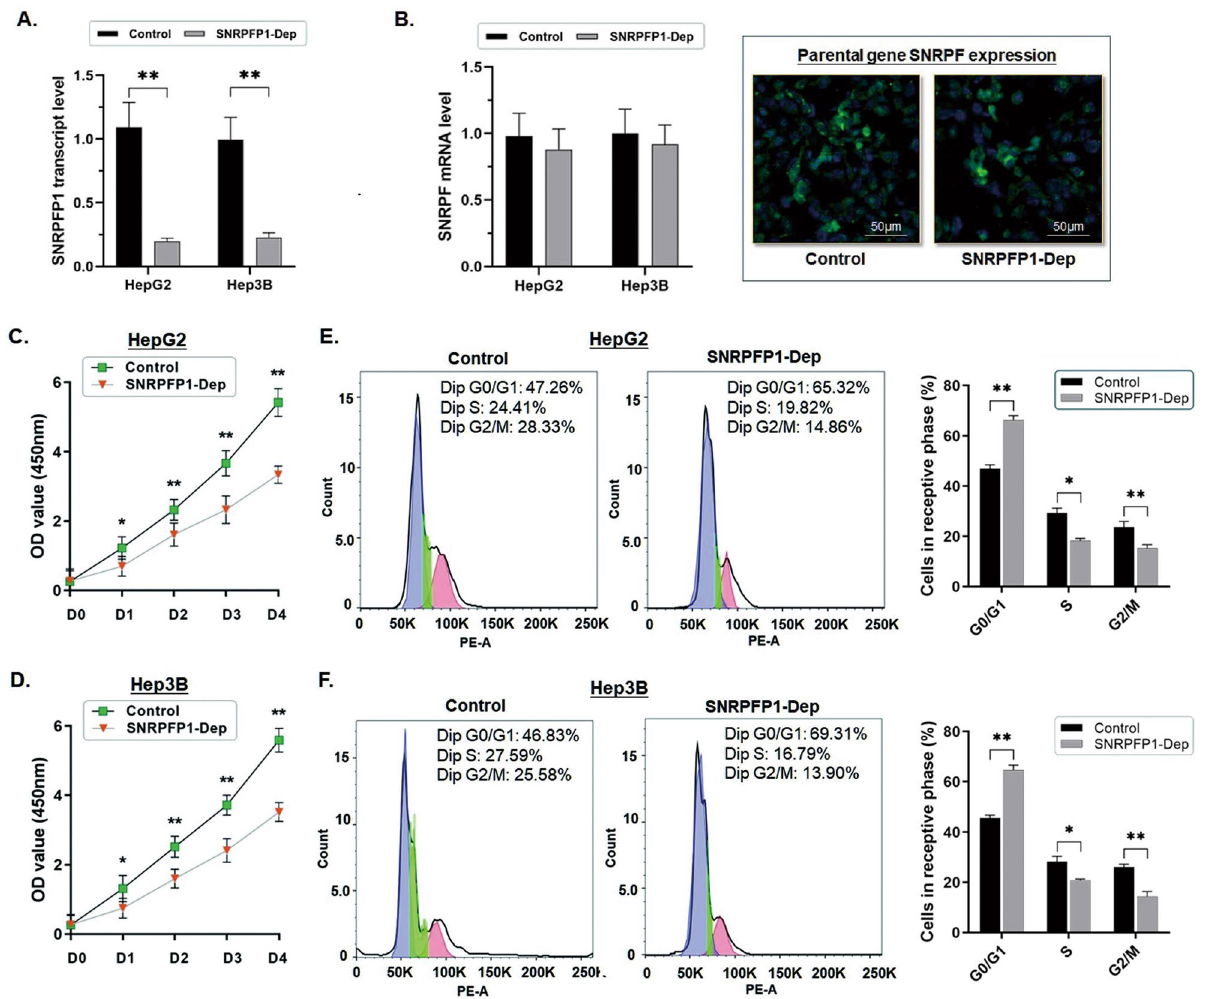
Figure 2. Depletion of SNRPFP1 represses cell proliferation in HCC cells and arrests cell cycles. ( A ) RT-qPCR assay was carried out to determine the effect of expression depletion on SNRPFP1 transcript in HCC cells. Depletion of SNRPFP1 transcript was conducted in HepG2 and Hep3B cells by using shRNA transfection. The RT-qPCR assay demonstrated the significant abrogation of SNRPFP1 transcript in both HepG2 and Hep3B cells (** P < 0.01). ( B ) The RT-qPCR assay and immunofluorescence were conducted to determine the change in the expression of the parental gene SNRPF when SNRPFP1 was depleted in HepG2 and Hep3B cells. No significant change in SNFPF expression was induced when the SNRPFP1 transcript was depleted. And the green fluorescent density indicating SNRPF expression in HCC cells made no significant change in comparison with the control. ( C,D ) The Flow cytometry detection of the cell cycle demonstrated that when SNRPFP1 transcript was abrogated in either HepG2 or Hep3B cells, the ability of cell proliferation was significantly impaired (* P < 0.05; ** P < 0.01). ( E,F ) Flow cytometry was used for analyzing the cell cycle. The representative histograms demonstrate the cell cycle status in HepG2 and Hep3B cells. The cell cycle of both HepG2 and Hep3B cells was significantly arrested in G0/G1 phase by depleting the SNRPFP1 transcript. The results are means of three independent experiments ± SD. (* P < 0.05, ** P <